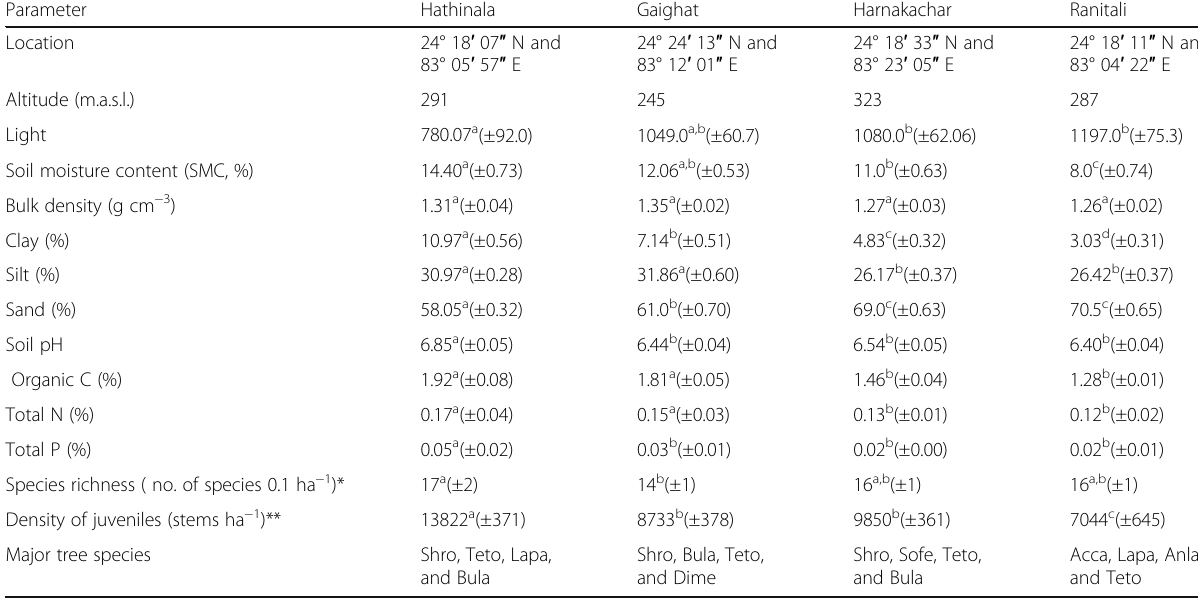
Table 1 Location, light, and physicochemical properties of soil and major tree species of four study sites